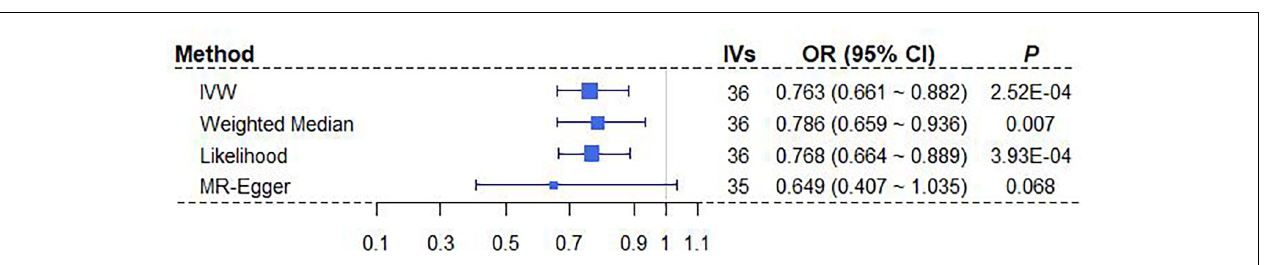
Frontiers in Genetics |